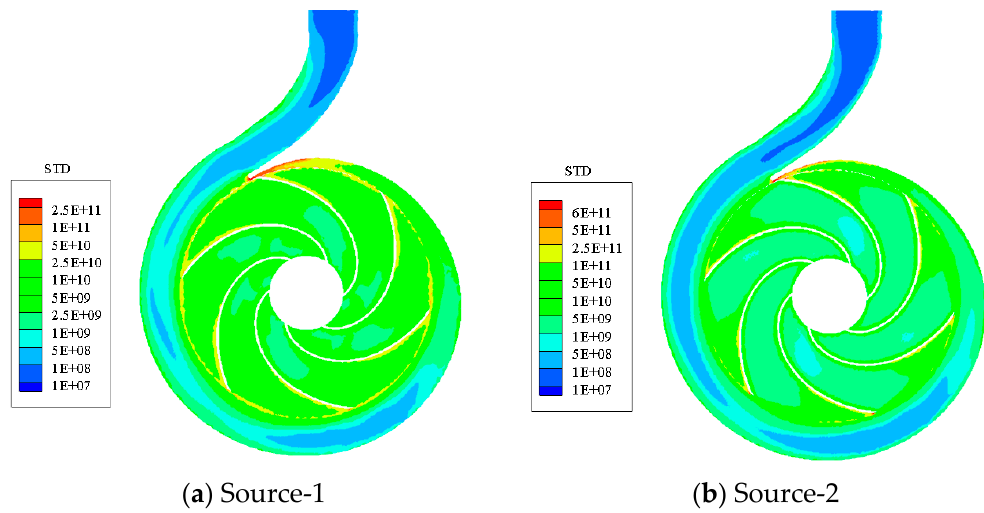
Figure 8. The STD distribution characteristics of different acoustic source components.